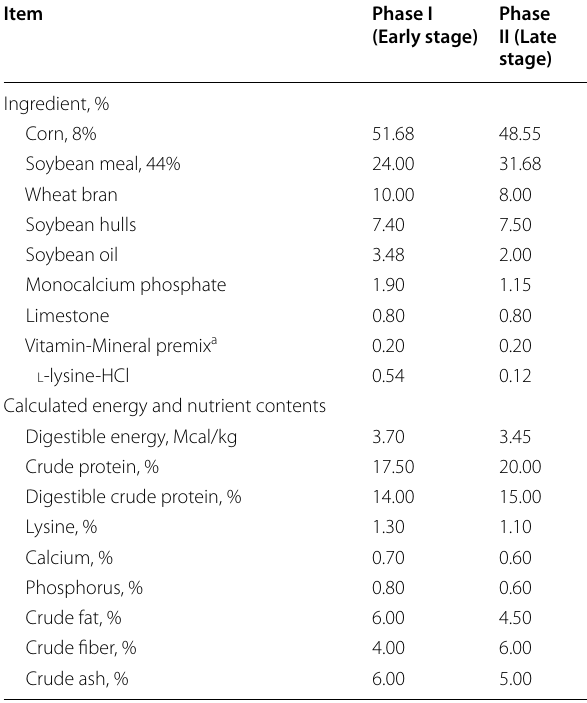
a Vitamin–mineral premix provided the following quantities of vitamin–mineral per kilogram of basal diet: vitamin A, 12,000 IU; vitamin D3, 2500 IU; vitamin E, 30 IU; vitamin K3, 3 mg; D-pantothenic acid, 15 mg; nicotinic acid, 40 mg; choline, 400 mg; vitamin B12, 12 µg; Fe, 90 mg from iron sulfate; Cu, 8.8 mg from copper sulfate; Zn, 100 mg from zinc oxide; Mn, 54 mg from manganese oxide; I, 0.35 mg from potassium iodide; Se, 0.30 mg from sodium